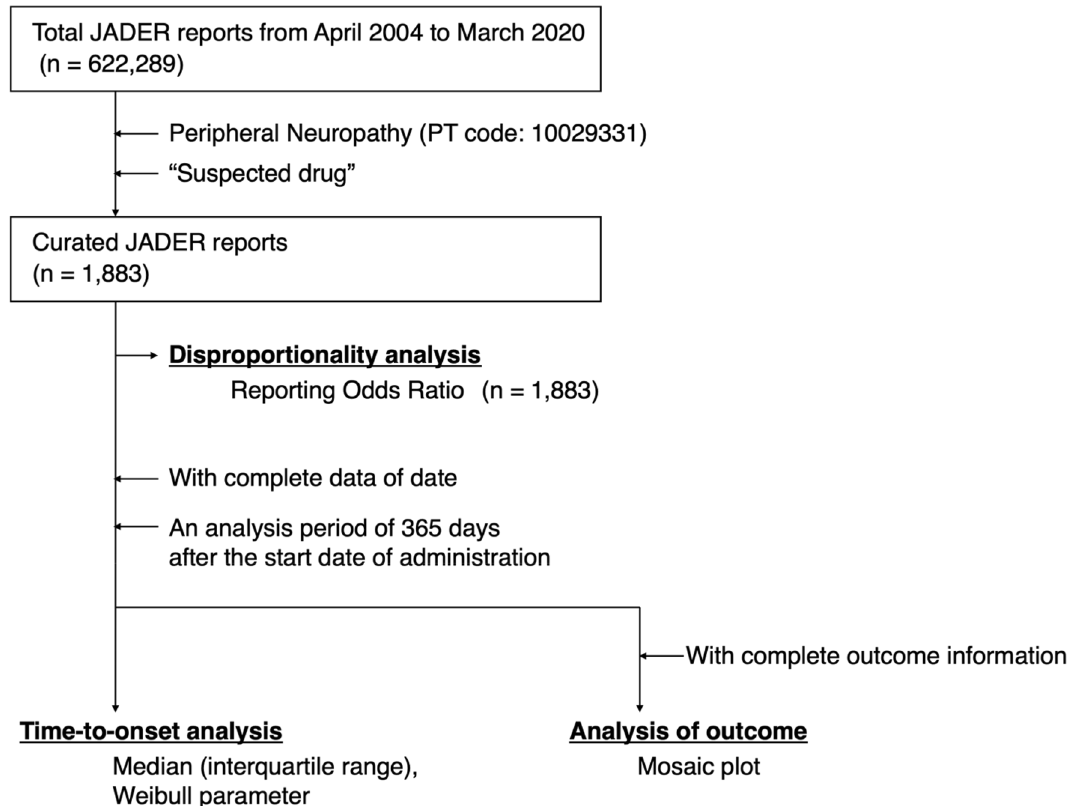
Figure 1. Flowchart outlining the construction of the dataset used for